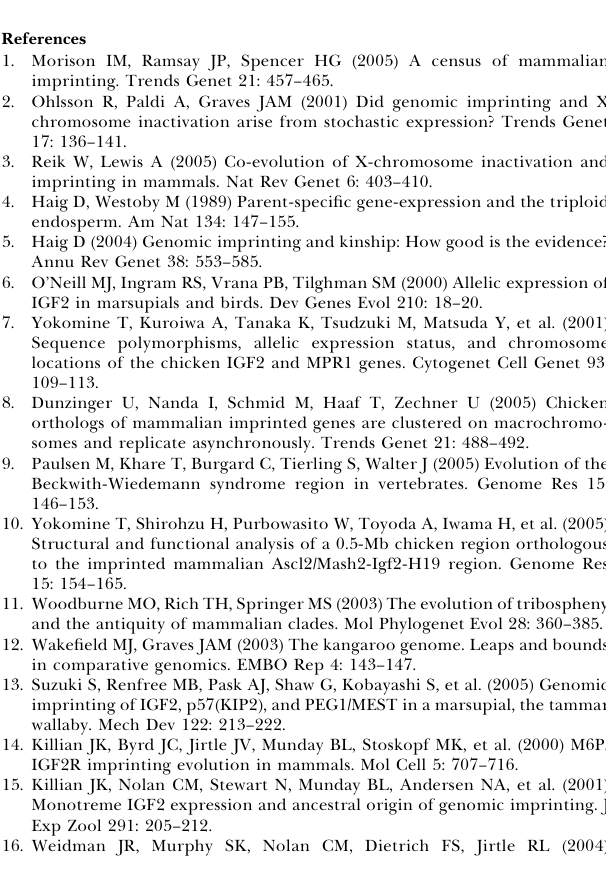
Table S3. Sm Protein Family Members Used in Phylogenetic Studies and Their Accession Numbers Found at DOI: 10.1371/journal.pgen.0020182.st003 (21 KB